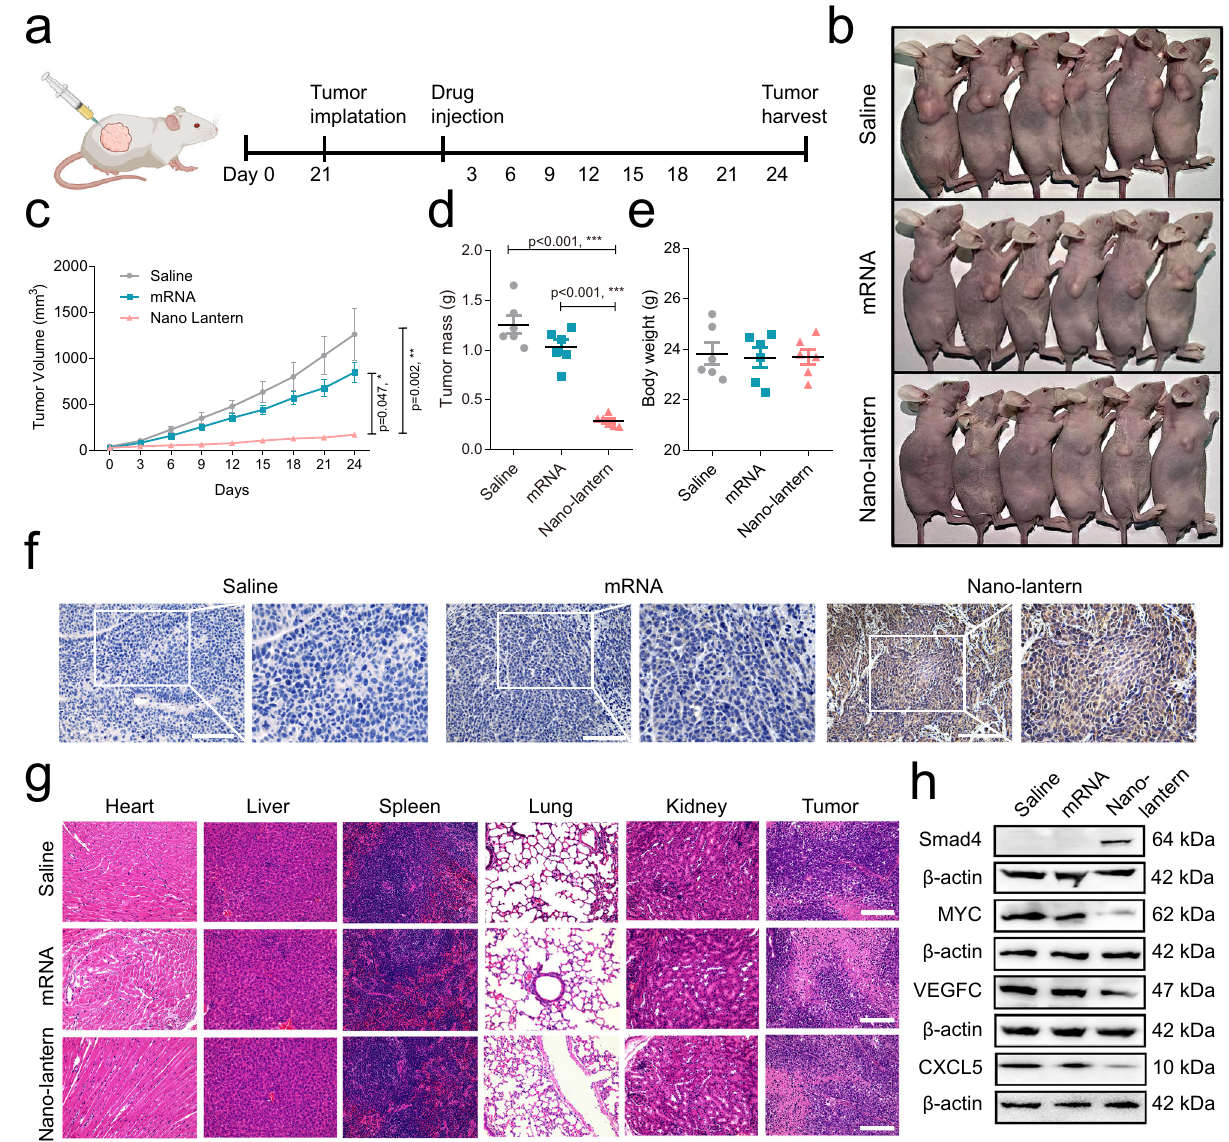
Fig. 8 | Tumor suppression of Smad4 mRNA nano-lantern in the subcutaneous model.a SystematicscheduleofSmade4mRNAnano-lanternadministrationinthe subcutaneous modelofSW480 cells. Created with BioRender.com. b Photographs of the subcutaneous tumor-bearing nude mice after treatment with saline, indivi- dual mRNA, and mRNA nano-lantern, respectively. c Images of the xenograft tumors at the endpoint ( n =6 mice/group). d Tumor growth curves of the tumor- bearing mice after treatment with saline, individual mRNA, and mRNA nano-lan- tern, respectively ( n =6 mice/group). e Body weight and tumor weight changes in the tumor-bearing mice with different treatments ( n =6 mice/group).